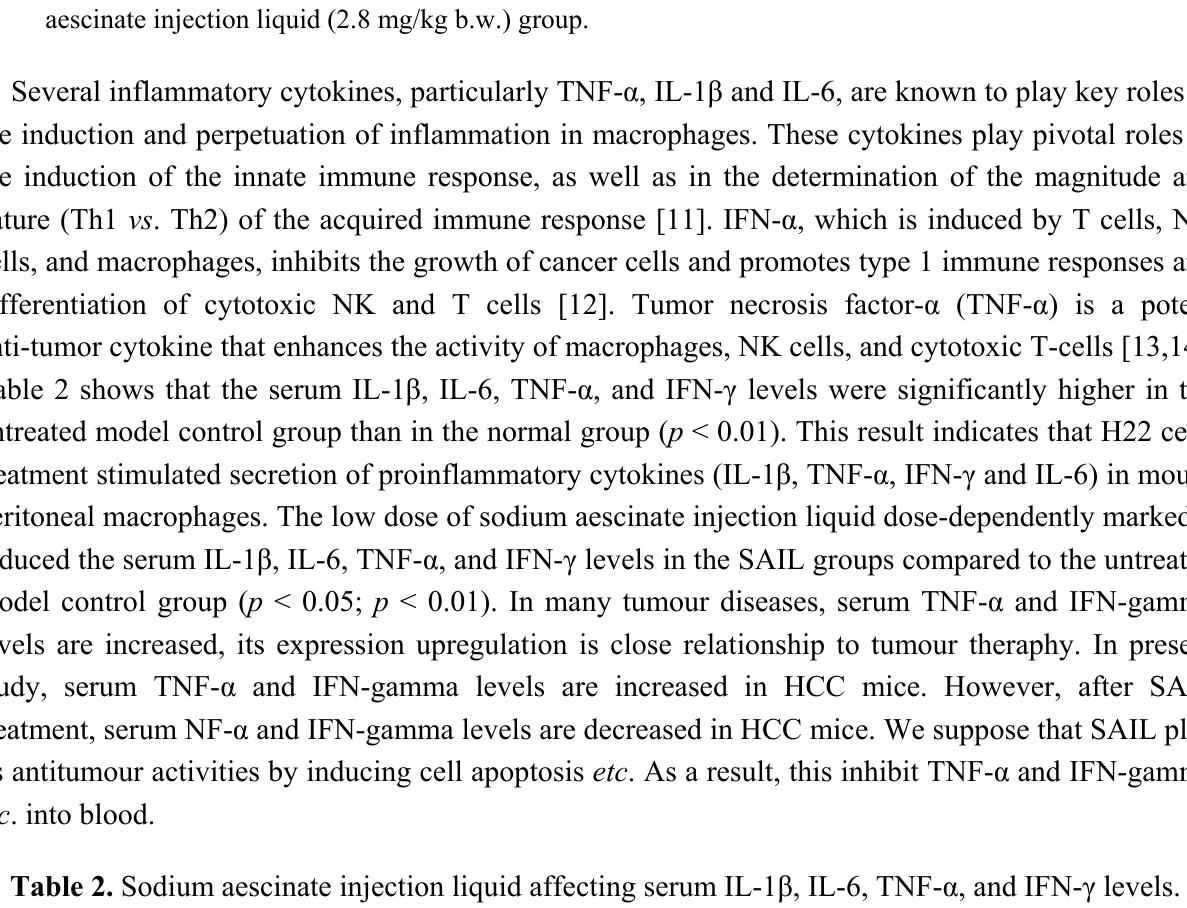
Table 2. Sodium aescinate injection liquid affecting serum IL-1 β , IL-6, TNF- α , and IFN- γ levels.